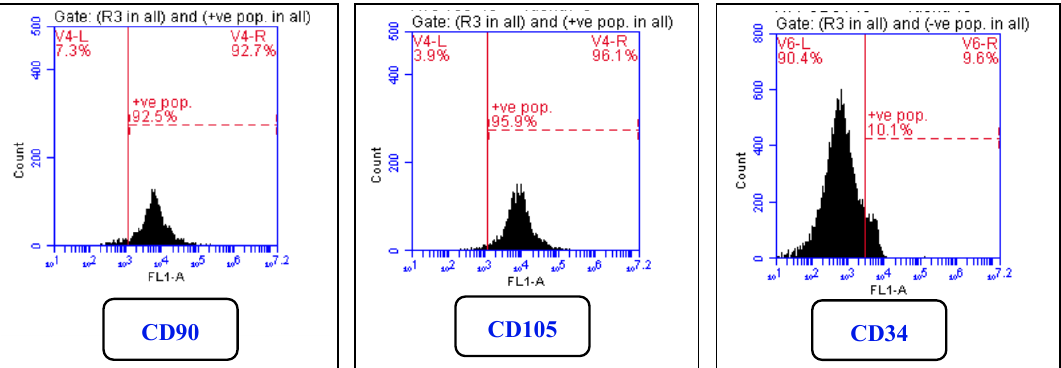
Figure 1. Histogram showing phenotypic cell-surface marker analysis of digested passage 3 (P3) Dental pulp stem cells (GMSCs). The GMSCs were highly positive for the mesenchymal markers CD90 and CD105 and were negative for the hematopoietic marker CD34.